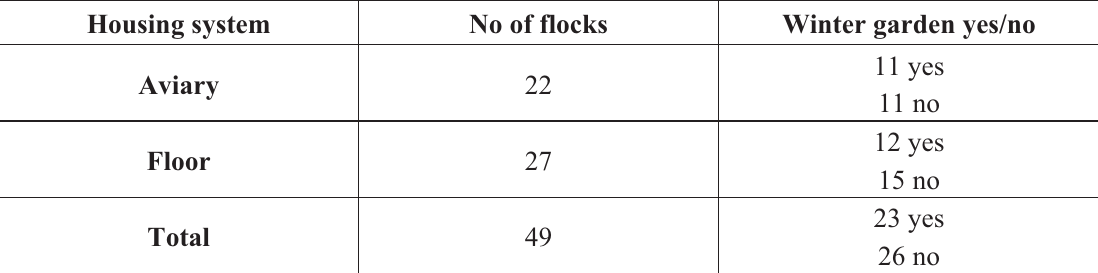
Table 3. Distribution of housing